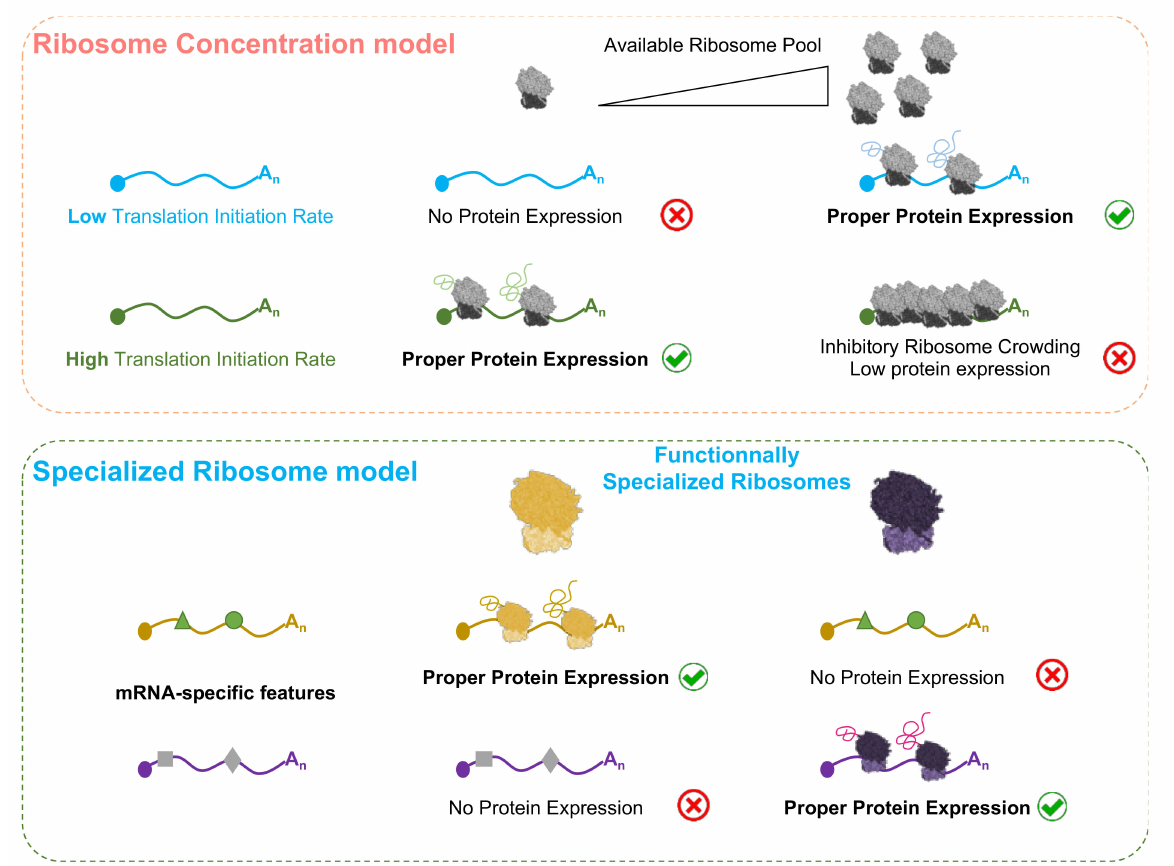
Figure 3. Ribosomes regulate gene-specific expression. Schematic diagram illustrating two models describing the impact of ribosome concentration on translation of specific mRNA subsets (upper panel) and the concept of functionally specialized ribosomes, which consists in heterogeneous ribosomes endowed with substrate selectivity (lower